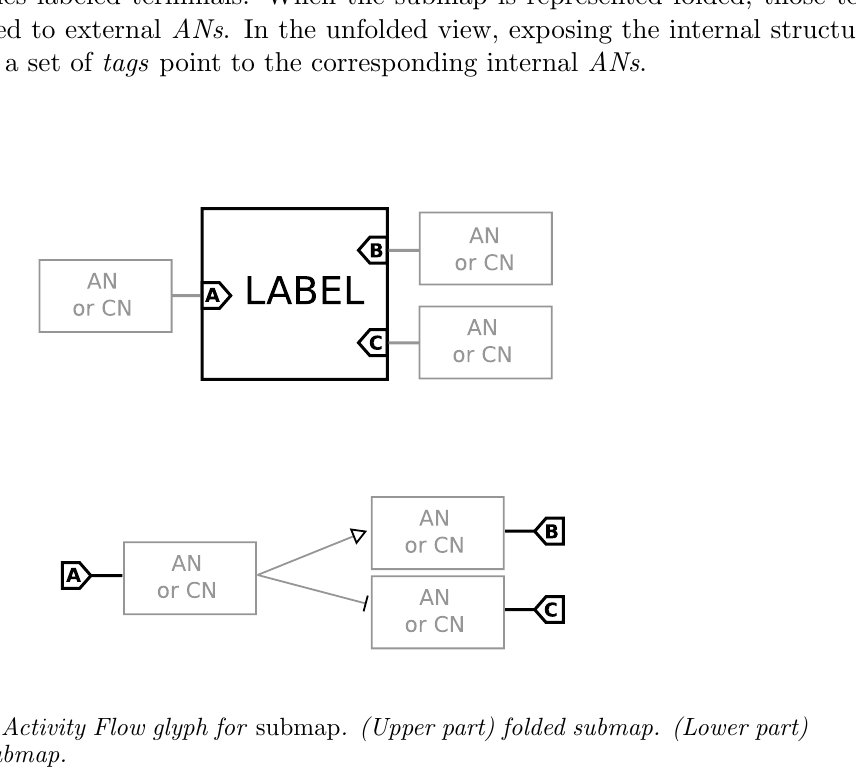
Figure 2.12: The Activity Flow glyph for submap . (Upper part) folded submap. (Lower part) content of the